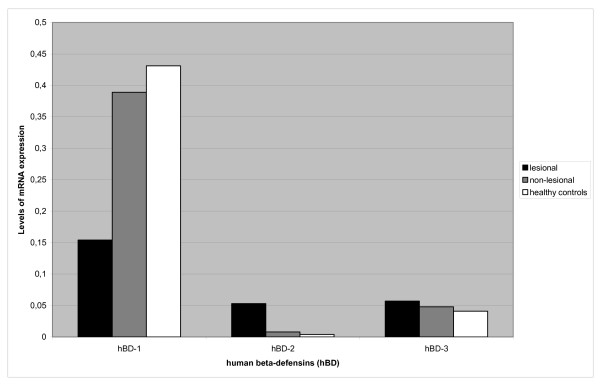
Diagram showing levels of median mRNA expression of hBDs in lesional and non-lesional skin of 22 patients with non-ulcerated basal cell carcinoma. hBD mRNA expression in 27 healthy controls is also shown. mRNA expression levels given on the y-axis correspond to the re-transformed logarithms of the ΔCt values.